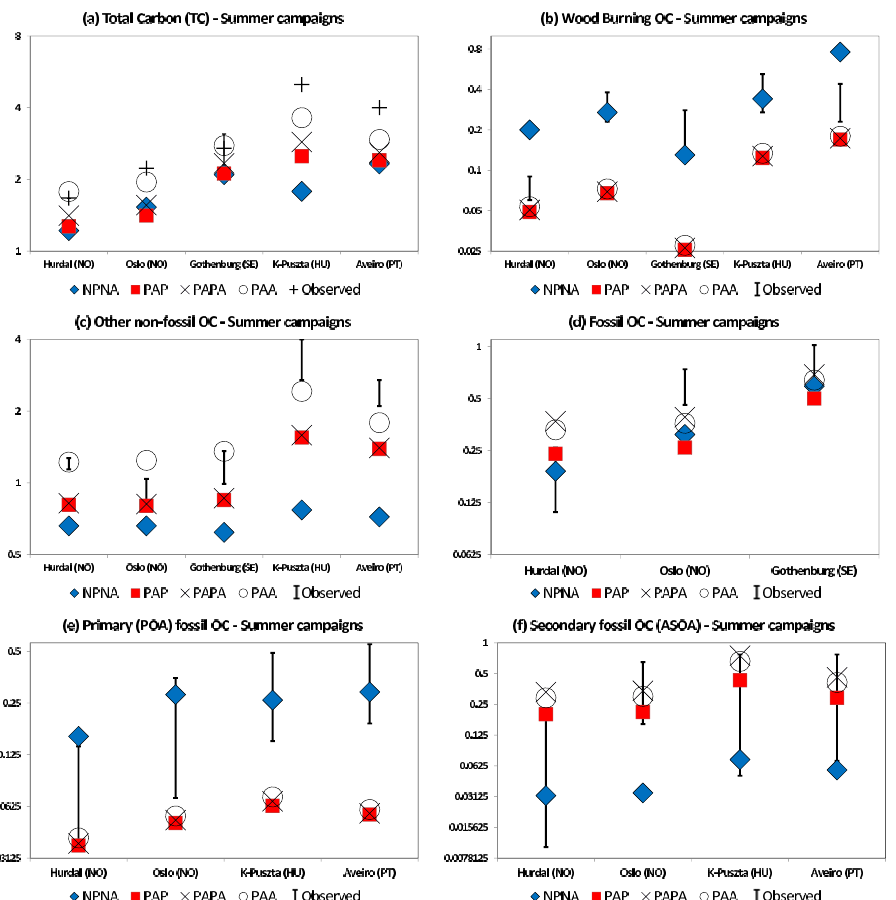
Fig. 10. Source apportionment studies during summer periods (May–October). Comparison of model results to observation-derived values for different source categories of organic carbon and for total carbon (units µg ( C ) m − 3 ). The observed values for the different source categories are based on a statistical approach (Latin-hypercube sampling) and given as 10–90th percentiles (SORGA and G¨ote campaigns: NO and SE stations) or 5–95th percentiles (CARBOSOL campaign: HU and PT stations). Further details, see text and Table